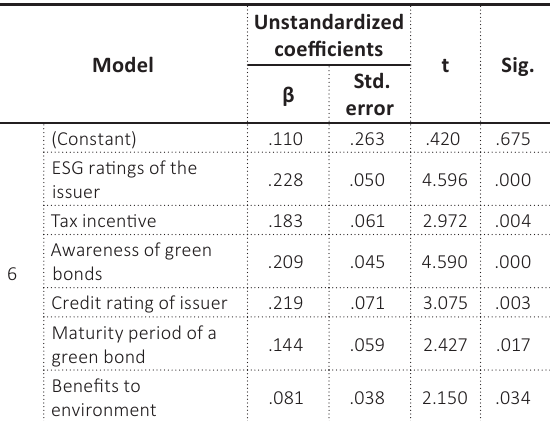
Table 4. Output of regression